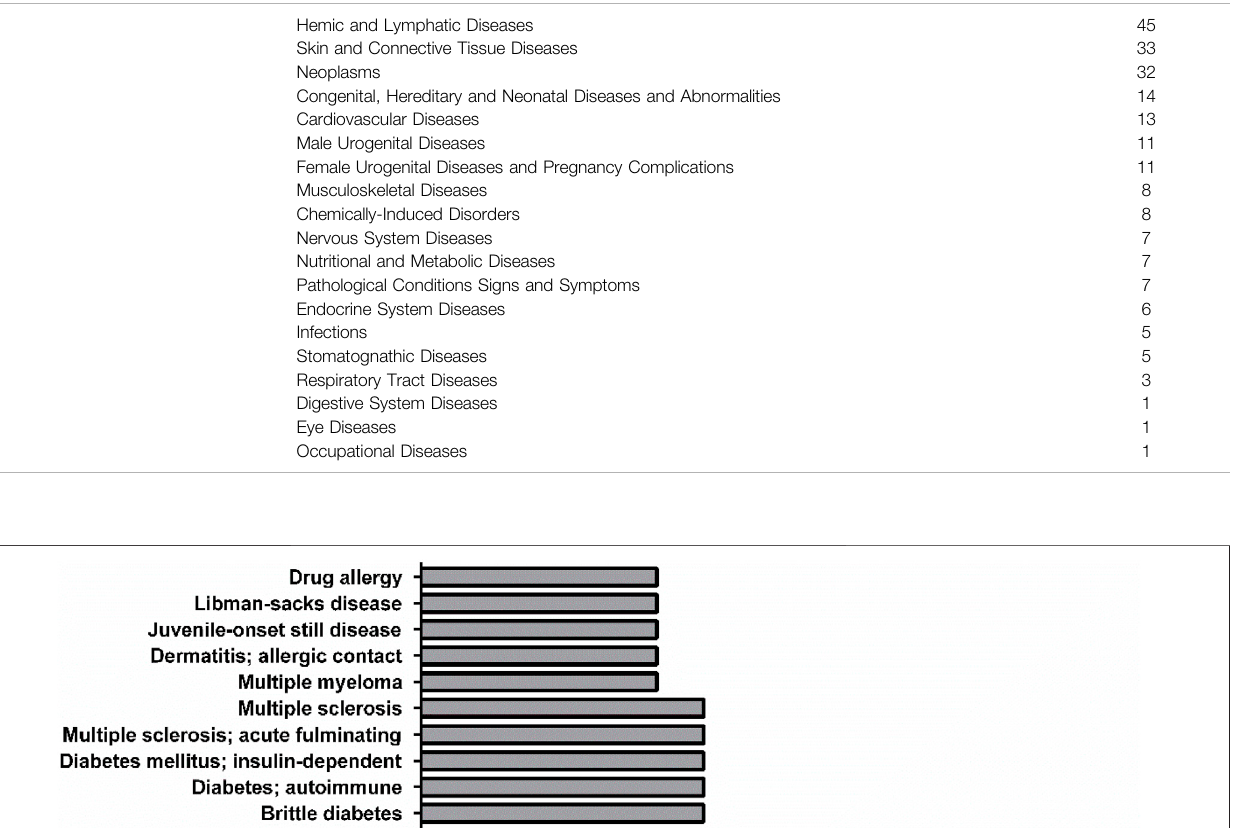
TABLE 1 | Group of diseases and number of diseases included within each group. Class